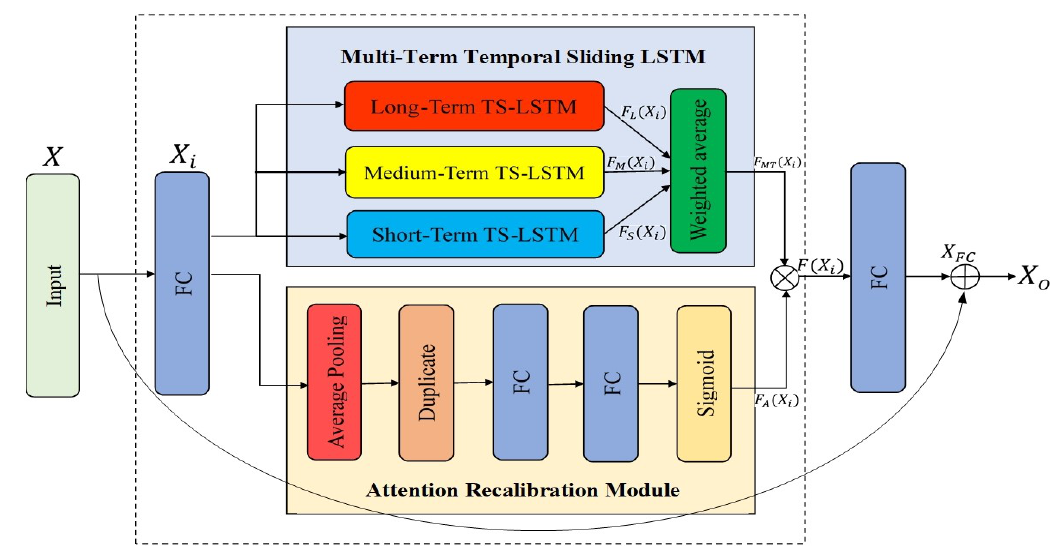
Figure 2. The structure of Multi-Term Attention Recurrent Neural Network (MTA-RNN), TS-LSTM: Temporal Sliding Long Short Term Memory. FC: Fully Connected